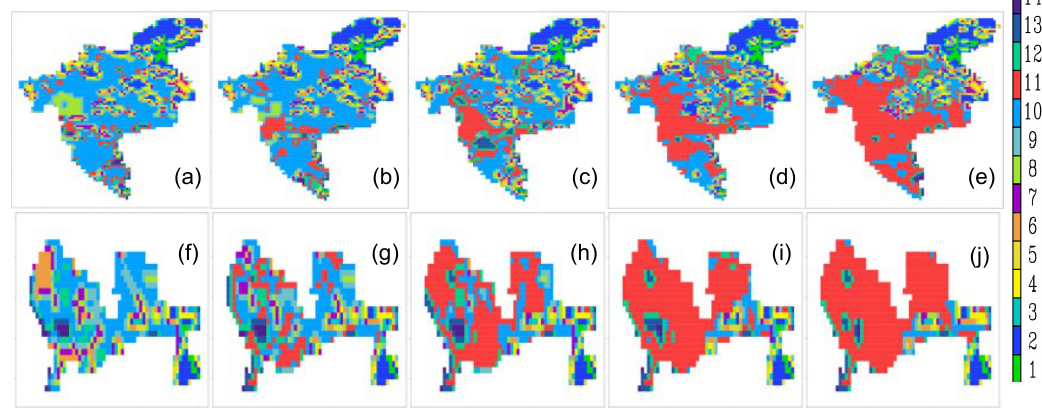
Figure 2. Spatial distributions of different land-use categories in ( a – e ) Guangzhou and ( f – j ) Shenzhen in the years of ( a , f ) 1980, ( b , g ) 1990, ( c , h ) 2000, ( d , i ) 2010, and ( e , j ) 2016, where red denotes urban surface grid cells. Land use categories are: (1) evergreen needleleaf forest, (2) evergreen broadleaf forest, (3) deciduous broadleaf forest, (4) mixed forests, (5) closed shrublands, (6) open shrublands, (7) woody savannas, (8) grasslands, (9) permanent wetlands, (10) croplands, (11) urban and built-up areas, (12) cropland/natural vegetation mosaic, (13) barren or sparsely vegetated areas, and (14) water. Source: [26].